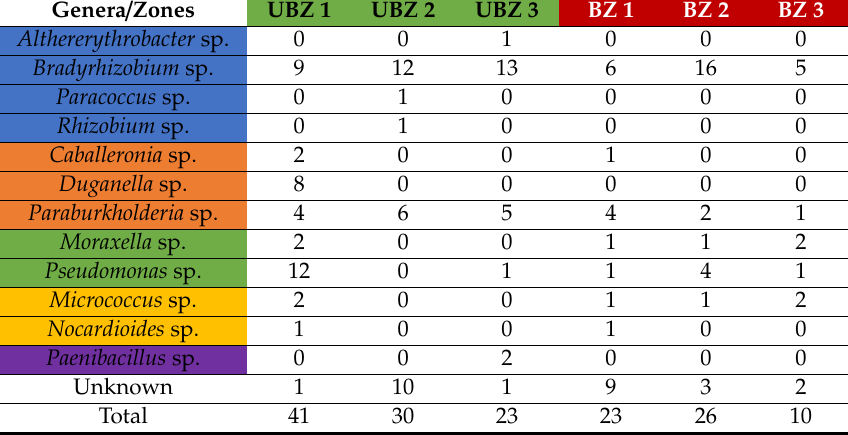
Table 3. Total of isolates identified within each unburnt (UBZ 1, UBZ 2, UBZ3) and burnt (BZ 1, BZ 2, BZ 3) zone. Colours indicate the phylum of each genus (Proteobacteria / α -proteobacteria (blue), Proteobacteria / β -proteobacteria (orange), Proteobacteria / γ -proteobacteria (green), firmicutes / Bacilli (purple) and actinobacteria / Actinobacteria (yellow). Genera / Zones UBZ 1 UBZ 2 UBZ 3 BZ 1 BZ 2 Bradyrhizobium